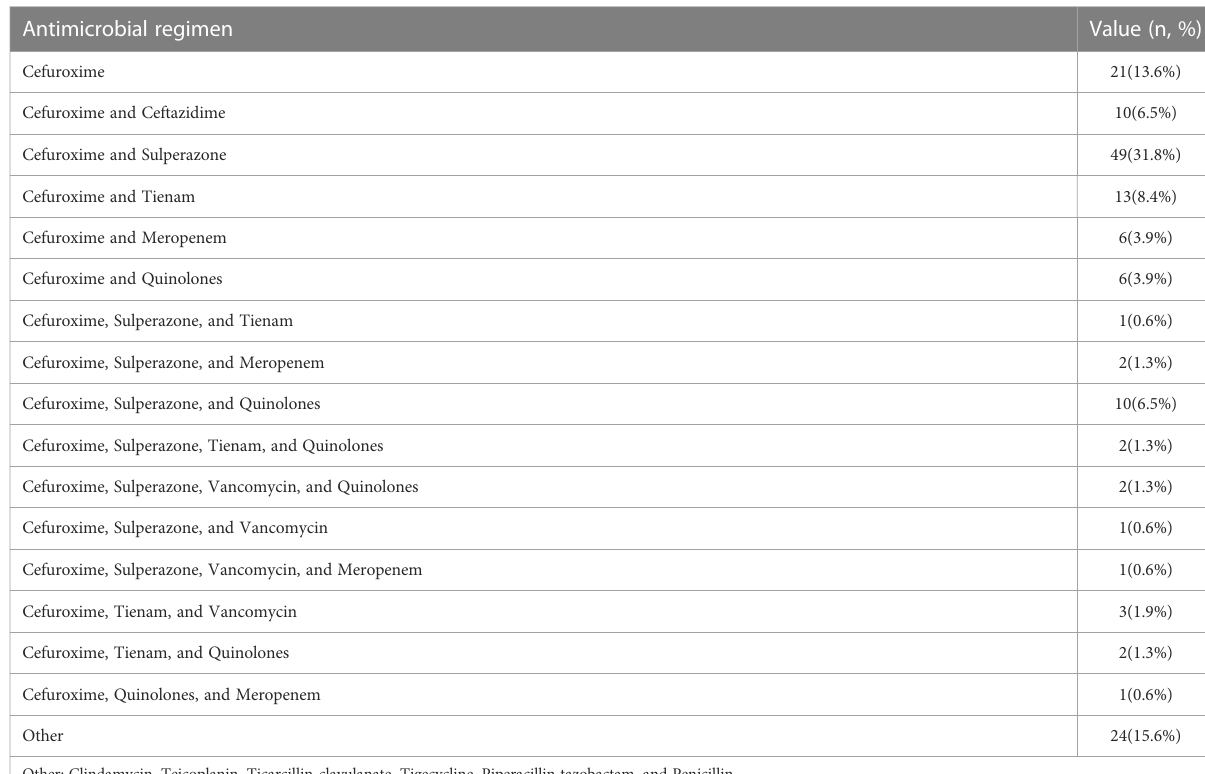
TABLE 2 Antibiotic regimen characteristics of antibiotic administration during the follow-up period. Antimicrobial